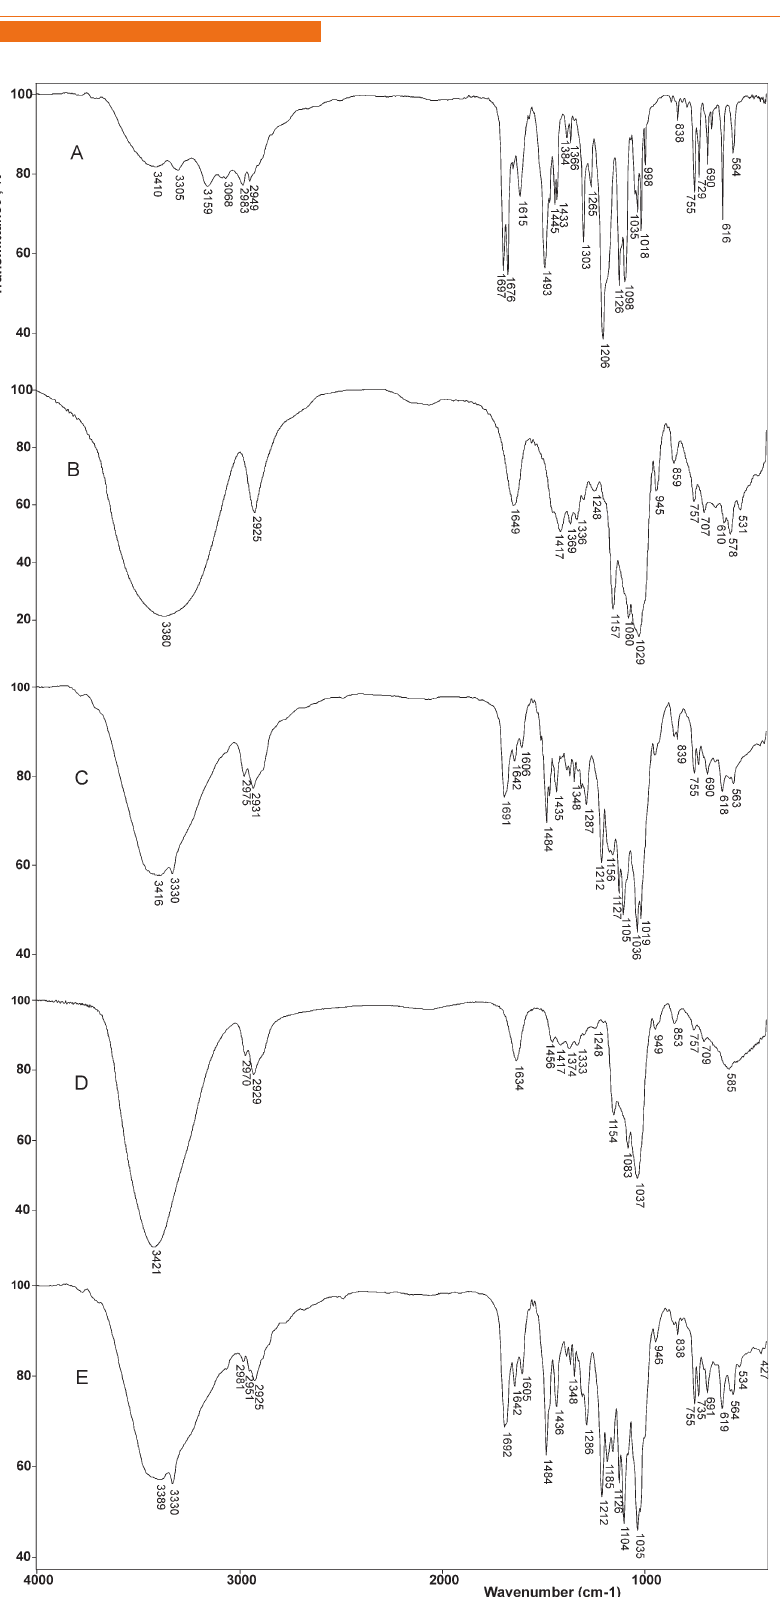
Figure 2. FTIR spectra of amlodipine besylate (A), β-cycldextrin (B), inclusion complex of β-cyclodextrin : amlodipine besylate (C), 2-hydroxypropyl β-cyclodextrin (D) and inclusion complex 2-hydroxypropyl β-cyclodextrin : amlodipine besylate